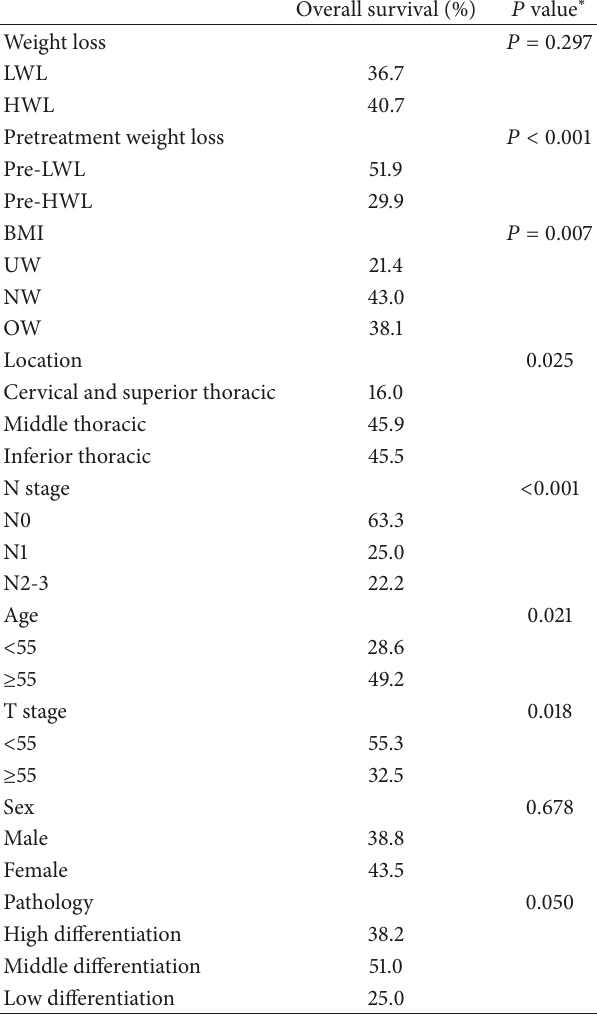
Table 2: Comparison of the 3-year overall survival in Kaplan-Meier analysis ( 𝑛 =